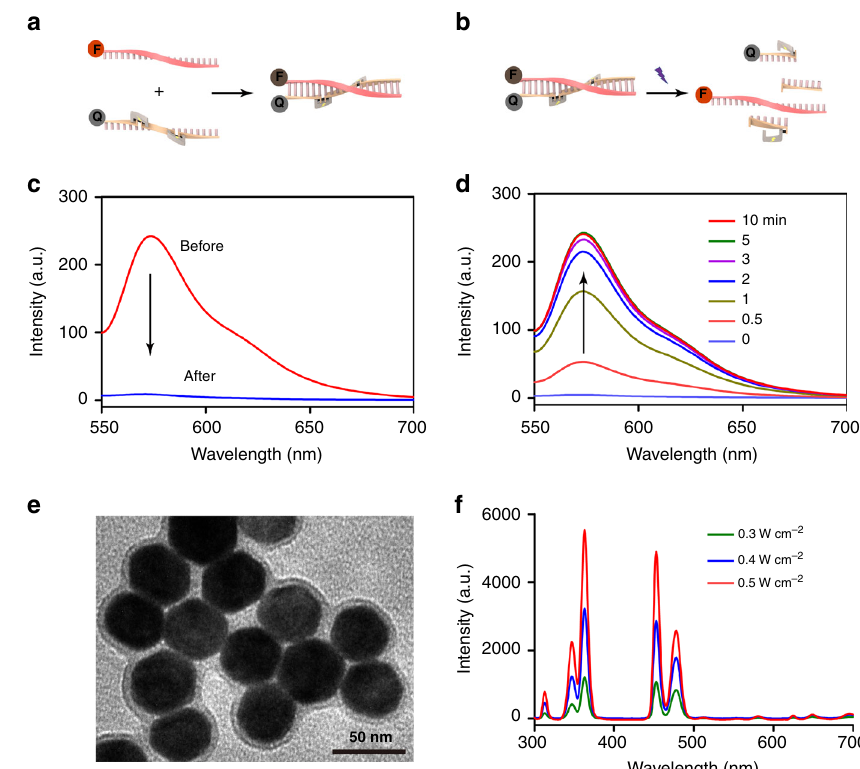
Fig. 2 Characterization of PCpG and PCpG/UCs. a Schematic of the design of FRET pair-labeled PCpG based on hybridization of fl uorophore (F, Cy3)- labeled CpG to quencher (Q, BHQ 2 )-labeled PcCpG. b Schematic of light-activated liberation of Cy3-CpG from the PCpG to enable FRET inhibition. c Fluorescence spectra of Cy3-CpG before and after formation of the PCpG. d Fluorescence spectra of FRET pair-labeled PCpG with increased dose of 365 nm light irradiation (5 mW/cm 2 ). e TEM image of PCpG/UCs. f Upconversion luminescence spectra of PCpG/UCs under 980 nm excitation of different power density. Source data are provided as a Source Data fi